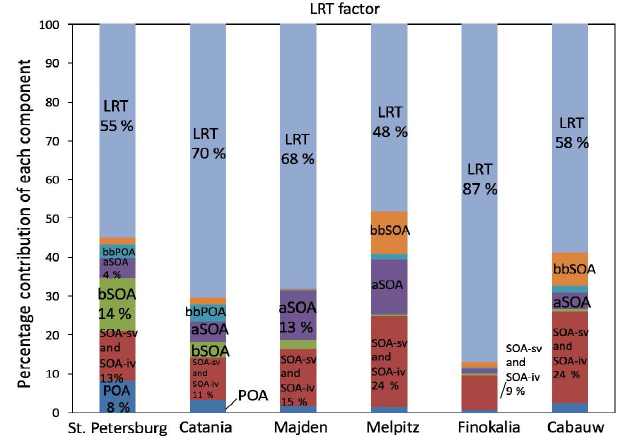
Figure 7. Contribution of each OA component to the PMCAMx- SR LRT factor in St. Petersburg, Catania, Majden, Melpitz, and Fi- nokalia during May